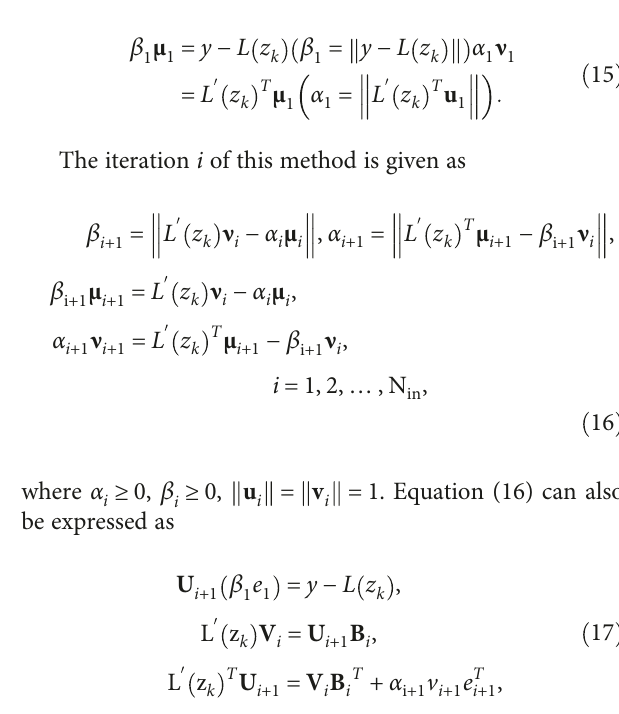
Algorithm 1: Algorithm fl ow of